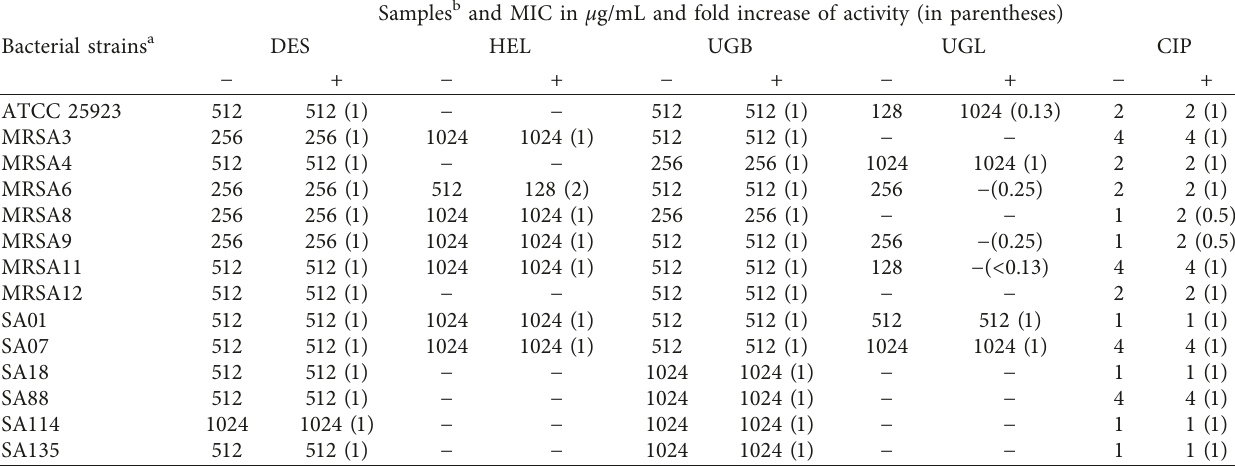
Table 6: MIC of extracts and ciprofloxacin in the absence ( − ) and presence (+) of chlorpromazine (CPZ) against selected strains of Staphylococcus aureus